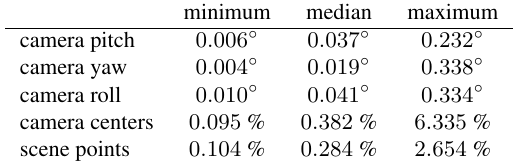
Table 2: Deviations of three estimated camera orientation an- gles, camera projection centers and scene point locations of the S YNTH 1 data set w. r. t. the approximate solution. Locations are in percent compared to the coordinate range of all cameras.